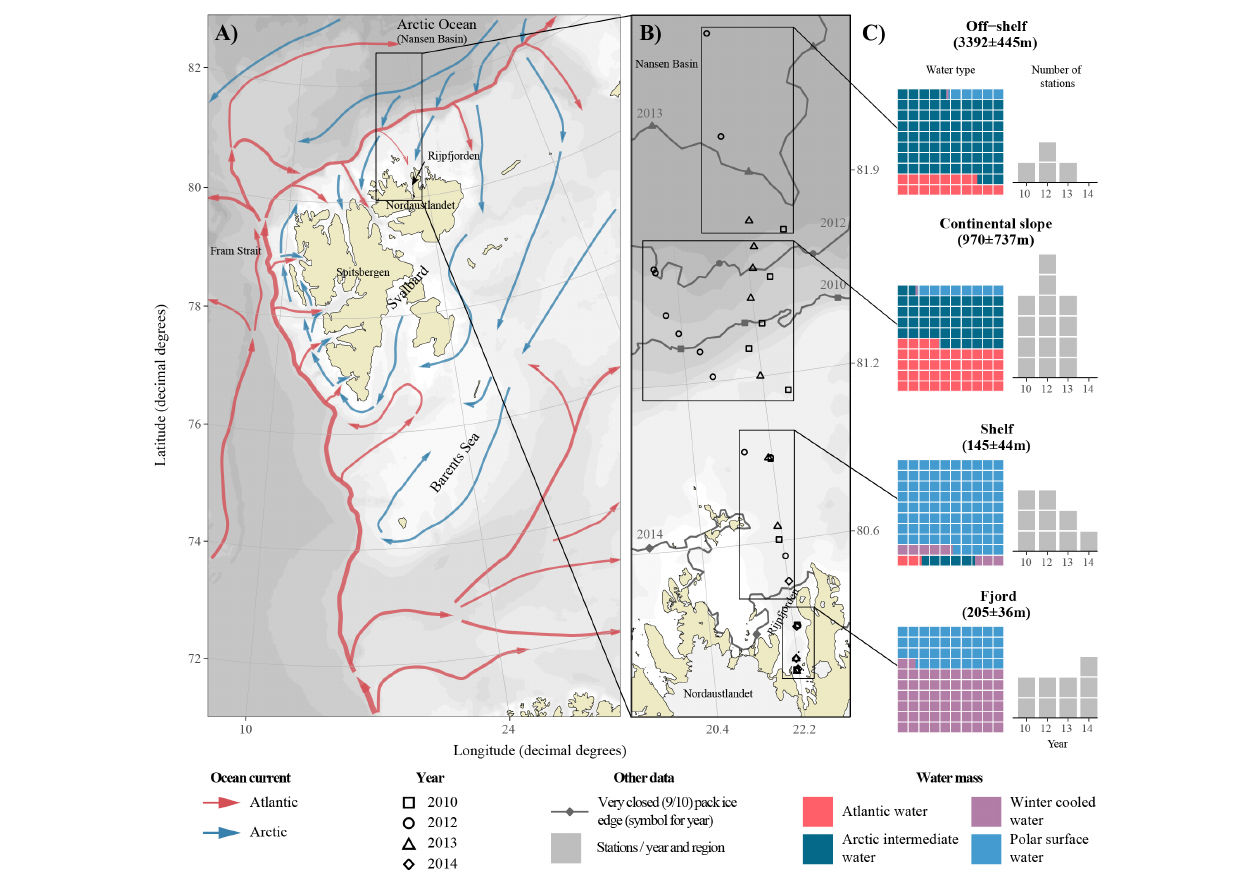
FIGURE 1 | Map of the study area. (A) Atlantic and Arctic Water currents around Svalbard (Vihtakari et al., 2019, modified from Eriksen et al., 2018). The study region is highlighted in a black rectangle. (B) Detailed location of transect stations during the 4 years. Black rectangles indicate the regions used in data categorization and gray lines represent the consolidated pack ice ( > 9/10 ice concentration) for each year. In 2014, the pack ice was present along the entire study area, and sampling was possible only in Rijpfjorden. (C) Average depth ( ± standard deviation), with waffle chart presenting the contribution of different water masses, and the number of stations for each region, represented as gray boxes. The waffle charts are arranged in 10 × 10% grid, with each cell representing 1% of water mass contribution. The number of stations for each year are represented as gray boxes.